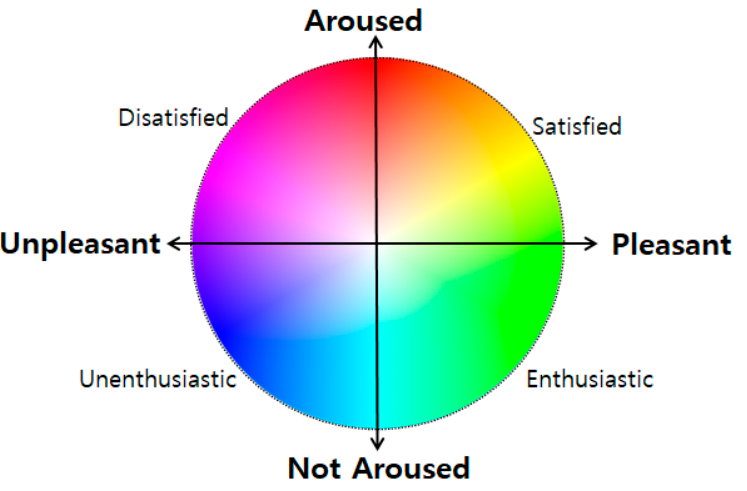
Figure 1. Russell’s human emotion model [20].